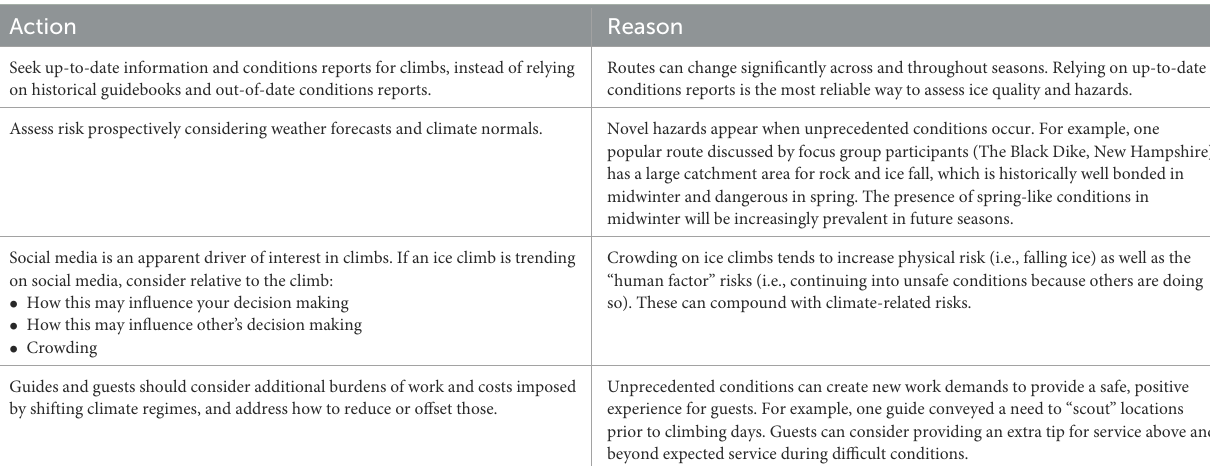
TABLE 2 Actions ice climbing participants can take to assess climate-related risks. Action